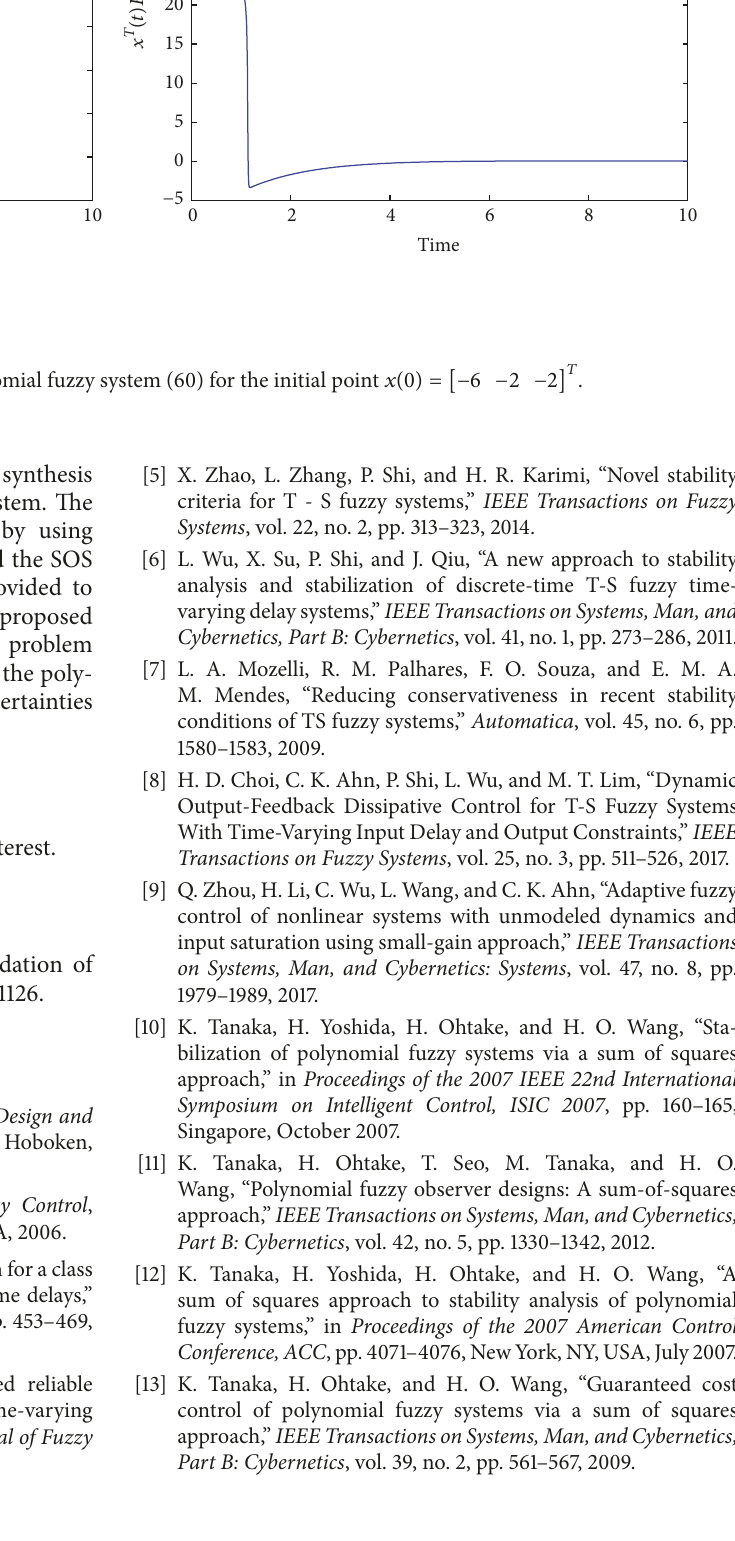
Figure 6: The state responses of polynomial fuzzy system (60) for the initial point 𝑥(0) = [−6 −2 −2]